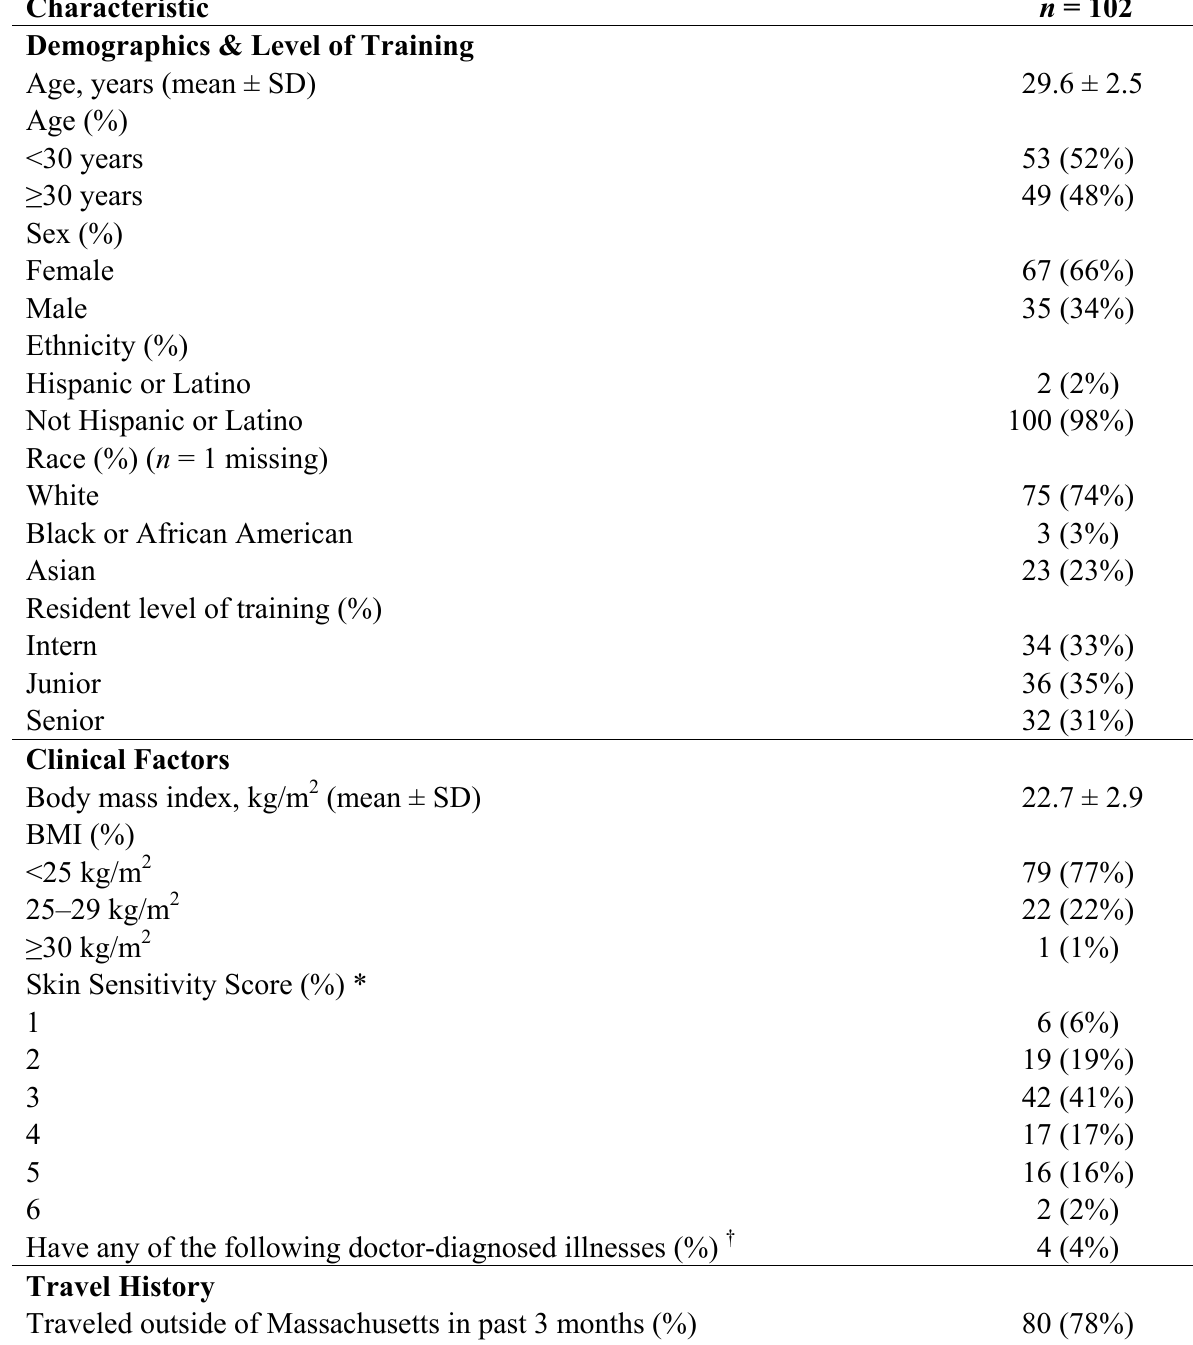
Table 1. Overview of Pediatric Resident